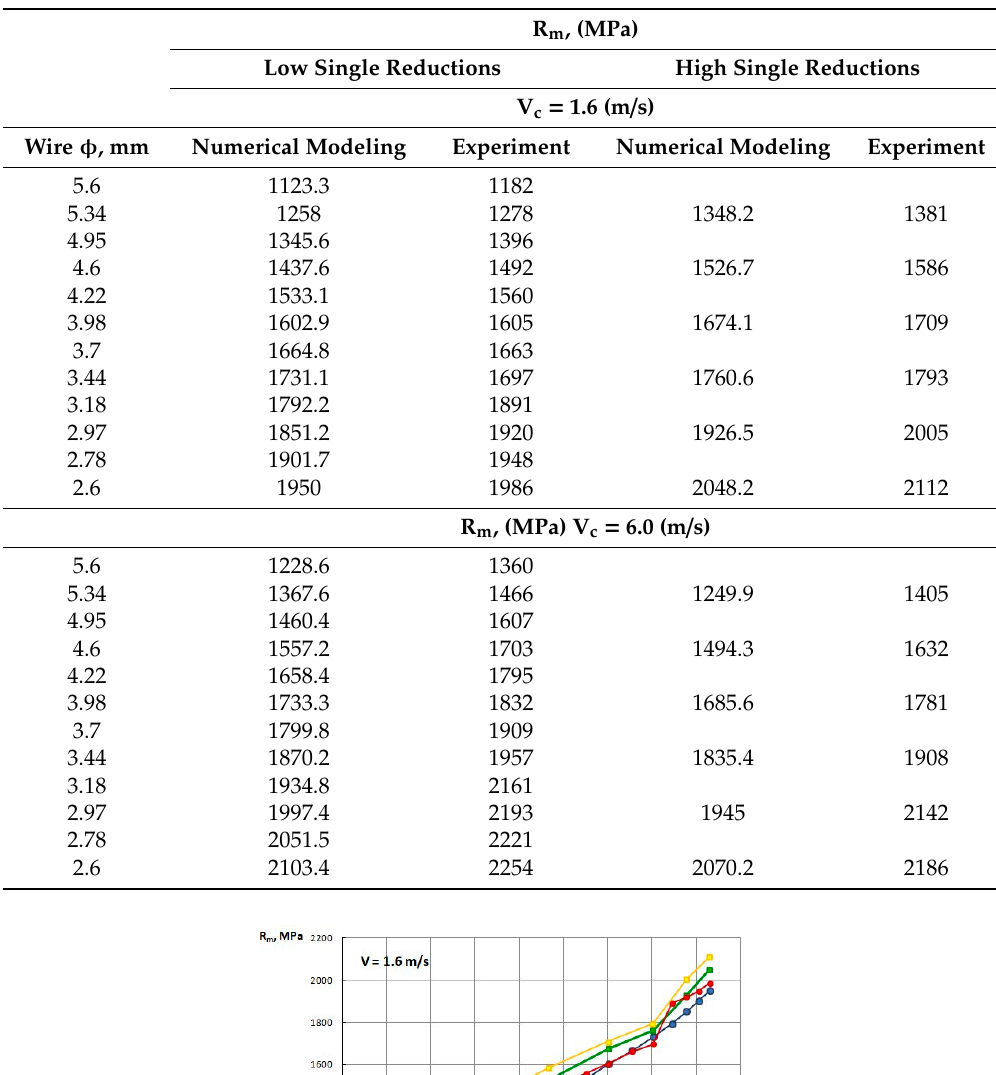
Table 9. Comparison of tensile strength test results for TRIP steel wires drawn with different speeds (V c = 1.6 m/s and V c = 6.0 m/s), and low (MG) and high (DG) single drawing reductions, determined through numerical modeling and an experiment.